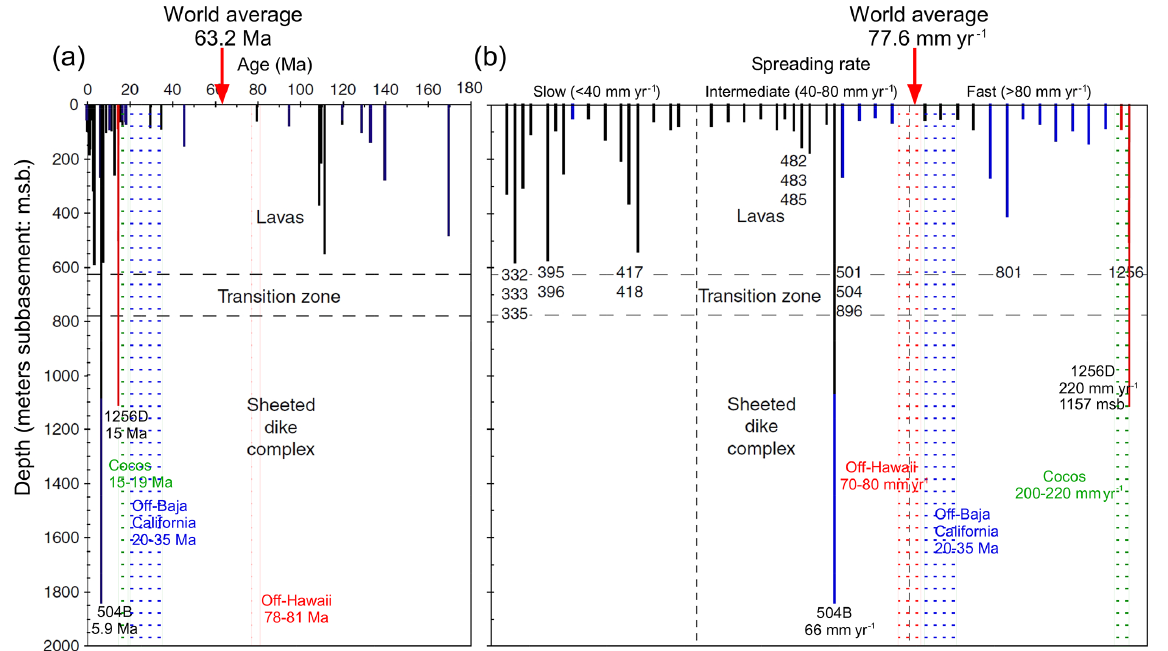
Figure 1. Ocean drill holes deeper than 50m into the oceanic basement plotted against (a) the basement age and (b) categorized on the basis of spreading rate that formed the basement crust. World average age and spreading rate are based on the 3.6min grid data from the Earth Byte age grid (Müller et al., 2008).